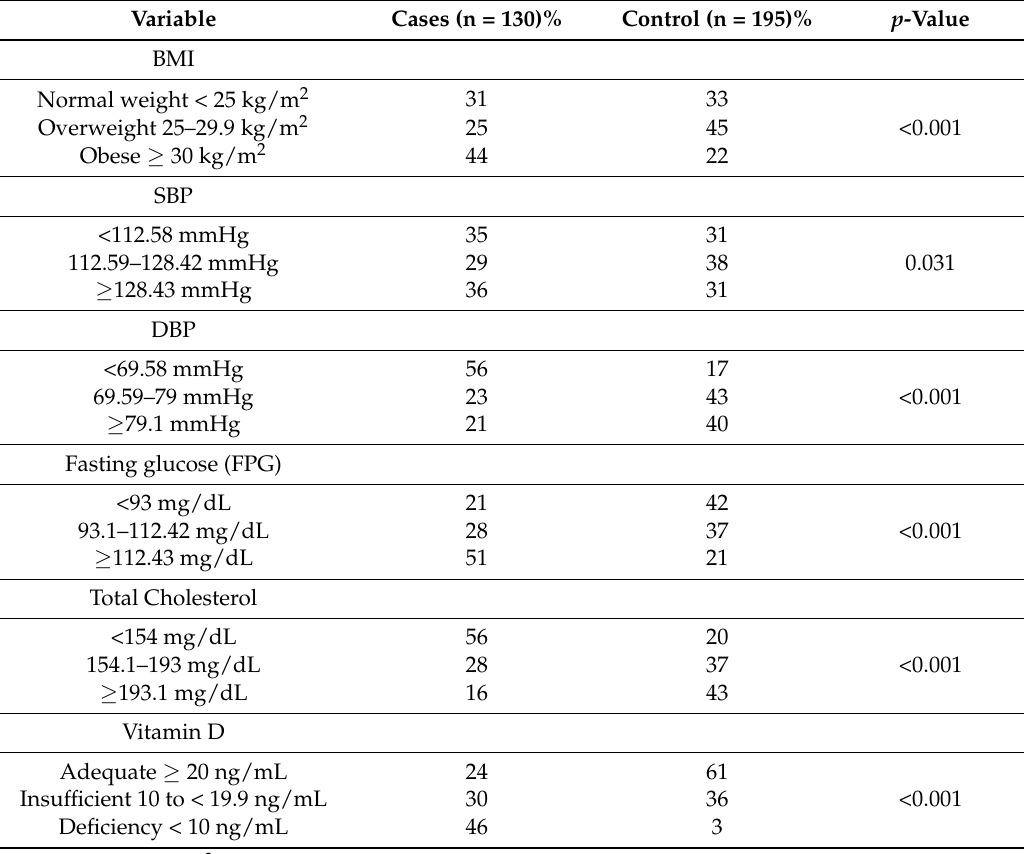
Table 2. Clinical characteristics of case and control subjects.